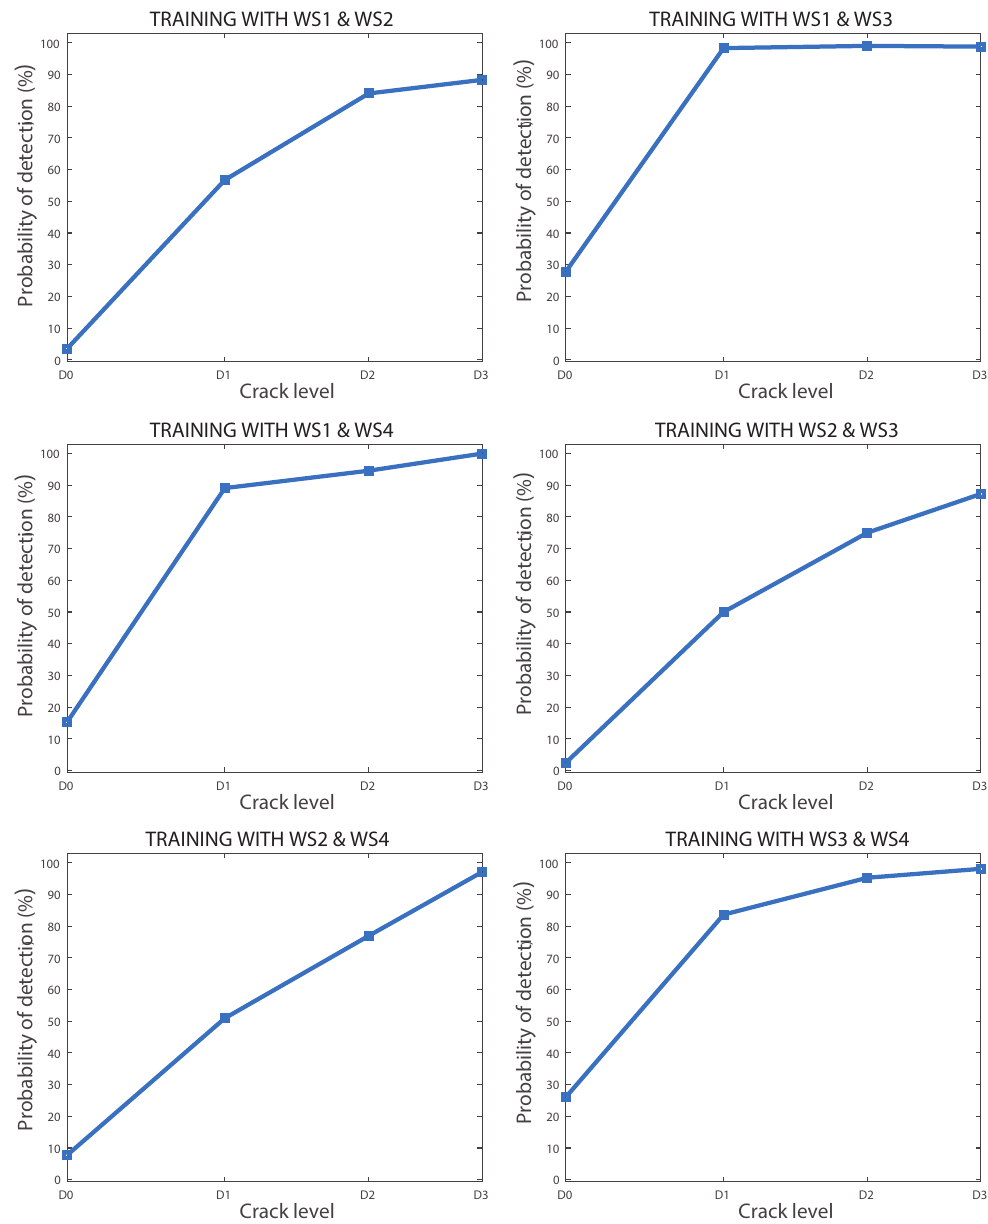
Figure 11. Probability of detecting a crack (%) for each crack size for all models where the data from two wheelsets were used for